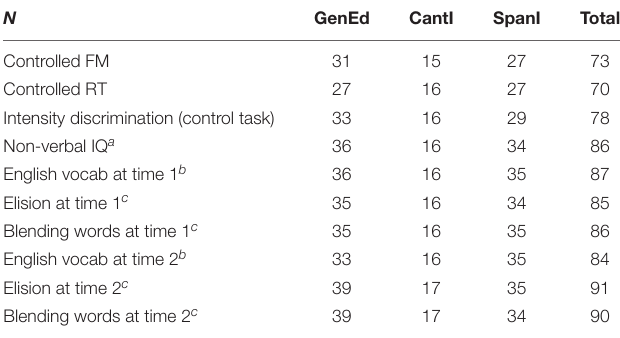
TABLE 2 | Final number of participants with complete and valid data for each